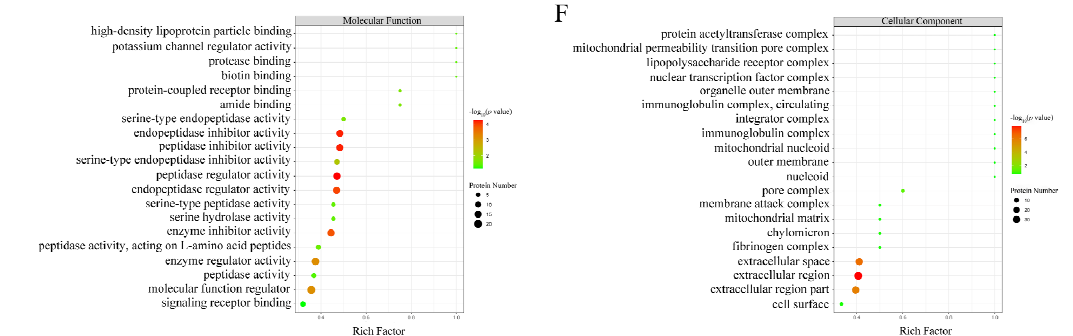
Figure 2. Domain analysis and GO annotation of differentially abundant proteins. Panels ( A , C ) rep- resent domain and GO annotation statistics of differentially abundant proteins, respectively. Vertical axis represents domain and GO term; horizontal axis represents the number of differentially abundant proteins corresponding to the domain and GO term. Panel ( B ) represents domain enrichment of differentially abundant proteins. Panels ( D – F ) represent GO function enrichment of differentially abundant proteins for biological processes, molecular functions and cellular components, respectively. Vertical axis represents different domain or GO function category; horizontal axis represents the enrichment factor ( ≤ 1; numbers of differentially abundant proteins associated with a domain or GO term/numbers of characterized proteins corresponding to the domain and GO term); the colors of the bubble indicate the significance of the enriched domain or GO terms; and the color gradient from green to red represents the increasing significant difference.